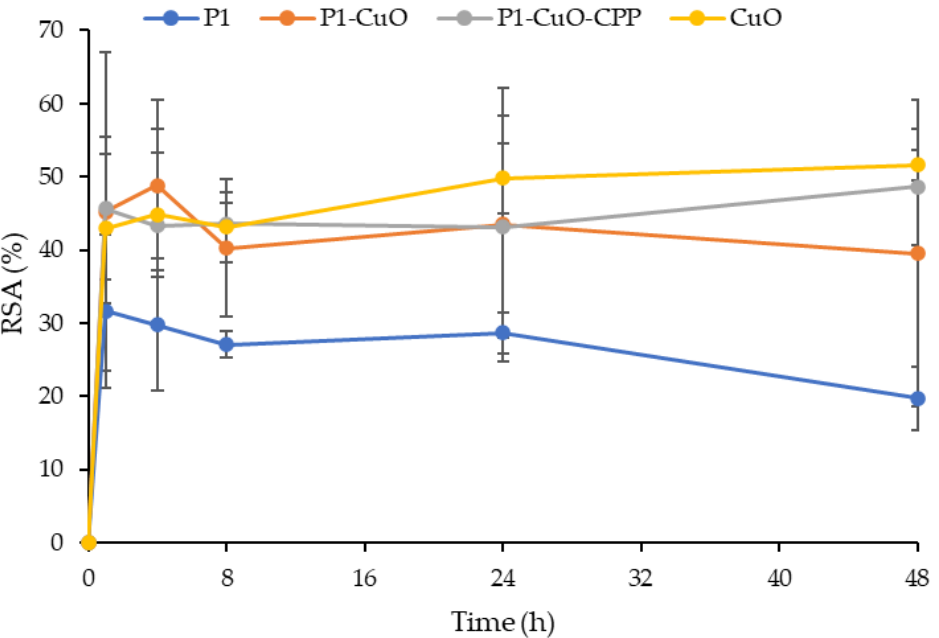
Figure 7. Radical scavenging activity (RSA%) evaluated via the DPPH assay for the P1, P1-CuO, and P1-CuO-CPP scaffolds and for the CuO and CPP powders alone (mean values ± SD, n = 5). One-way ANOVA, Scheffé test ( p ≤ 0.05) is reported in the Supplementary Information (SI: Section S1.3.3).